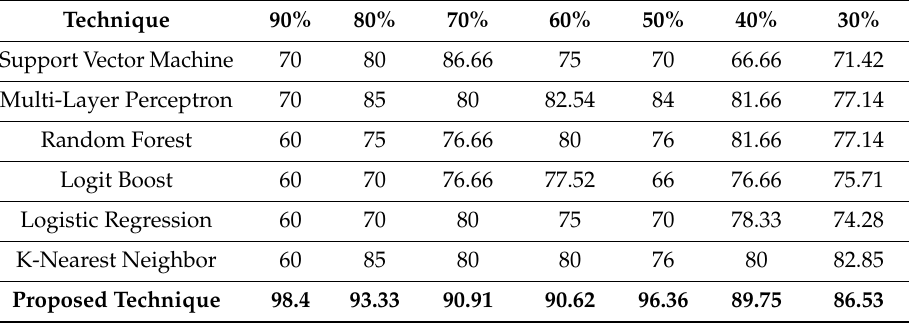
Figure 8. Confusion matrices with and without Fine-tuned configuration. ( a ) Confusion Matrix without Class balancer and Fine-tune. ( b ) Confusion Matrix with Class Balancer and Fine-tune. Table 3. Comparison of the proposed deep learning approach with other methods based on % training ratio.